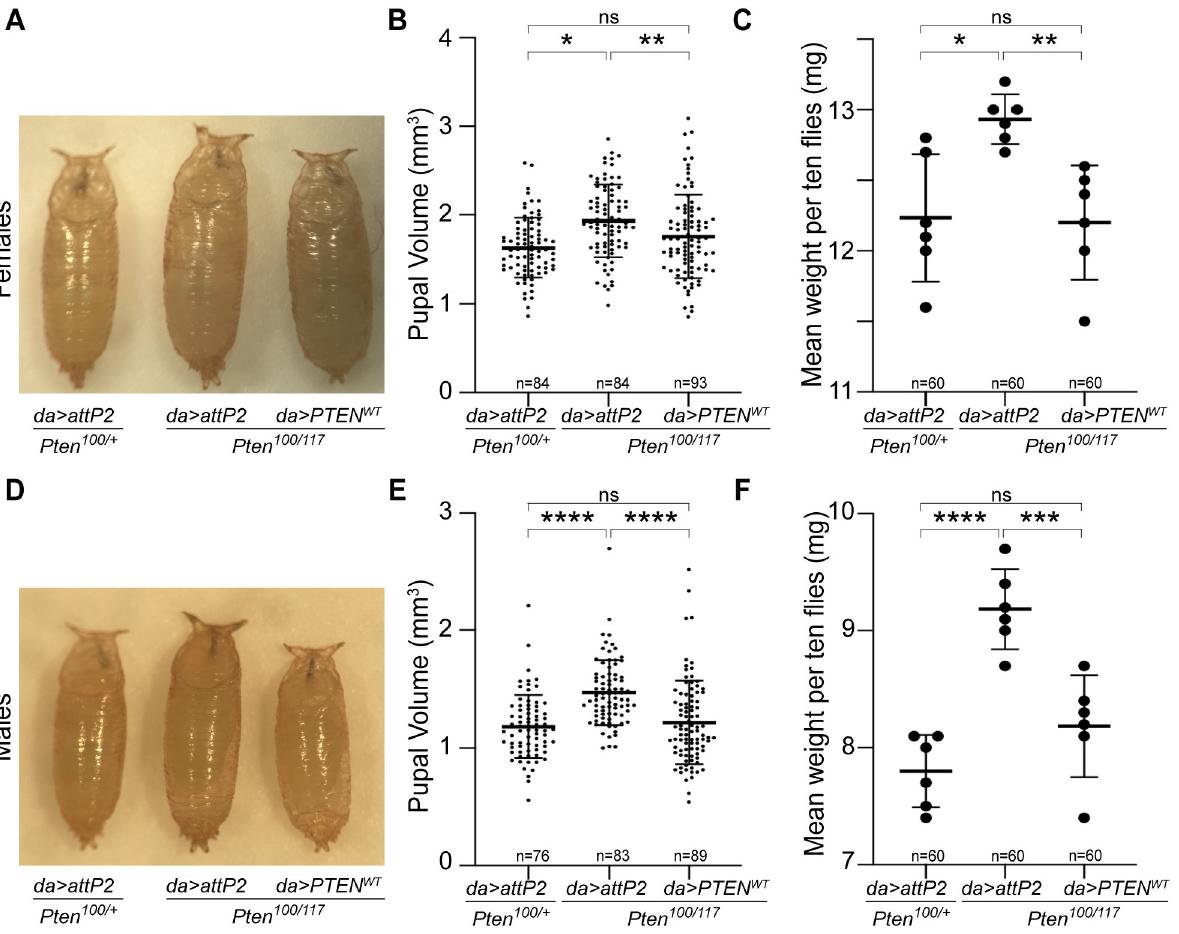
Fig 1. Ubiquitous expression of human PTEN rescues overgrowth of Drosophila Pten hypomorphic mutants. Representative images of female pupae (A) and male pupae (D) of Pten heterozygotes ( Pten 100 /+; da-GAL4/attp2) , Pten mutants ( Pten 100 /Pten 117 ; da-GAL4/attp2) , and Pten mutants rescued by PTEN ( Pten 100 /Pten 117 ; da-GAL4/UAS-PTEN-WT) . Graphs showing female and male pupal volume (B, E) , as well as female and male body weight (C, F) for each genotype shown. Sample size (n) is indicated for each genotype. Each datum point within scatter plots represents a single pupa (B, E) or the mean of 10 adult flies (C, D) . Expression of PTEN-WT in Pten strong hypomorphs rescued pupal volume and adult body weight in both sexes. Data expressed as mean ± SD and analyzed using one-way ANOVA with Tukey HSD post-hoc ; � p < 0.05, �� p < 0.01, ��� p < 0.001, ���� p < 0.0001, ns = not